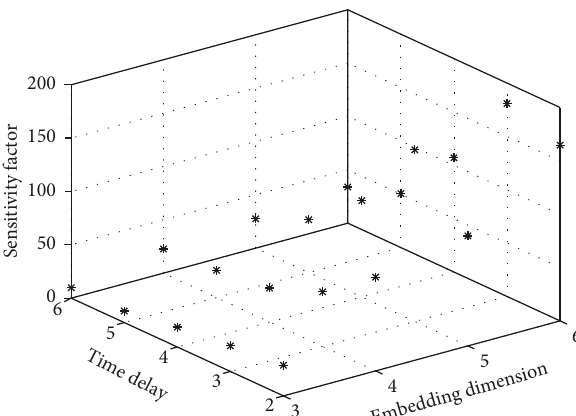
Figure 7: Three-dimensional distribution diagram of the sensitivity factor. Table 2: Statistical results of the sensitivity factor.